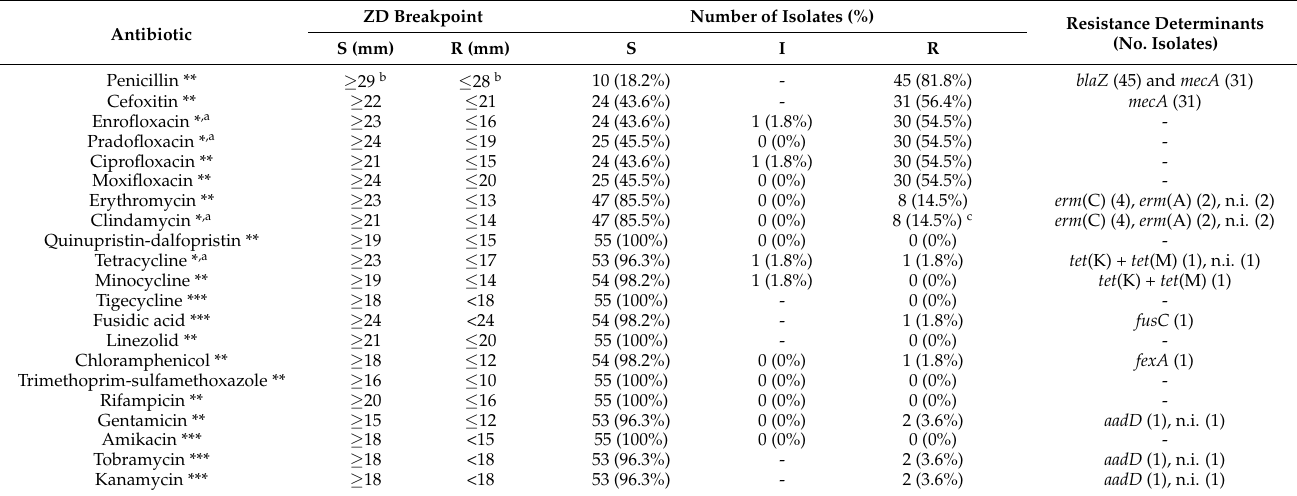
Table 1. Antibiotic susceptibility profiles and resistance genes for the 55 SSTI-related S. aureus isolates studied. Data are only presented for antibiotics with established